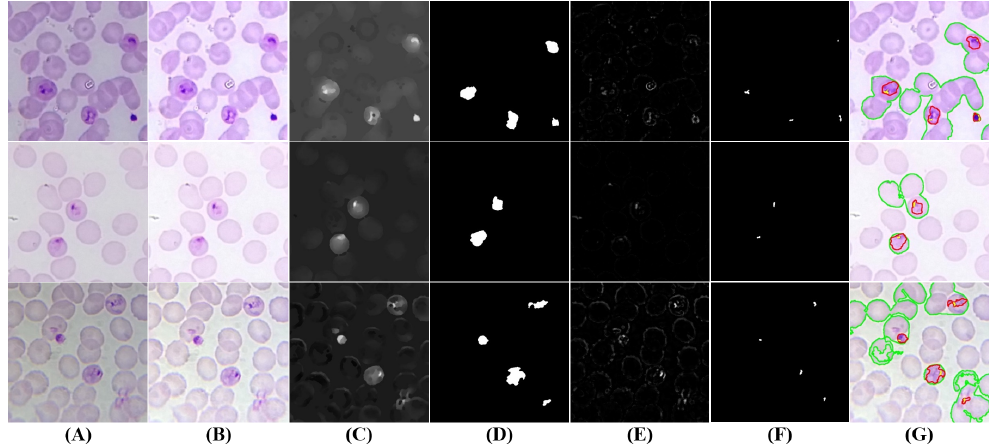
Figure 8. Examples of mature trophozoite stage candidates: ( A ) original image (cropped ROI); ( B ) brightness and contrast enhancement; ( C ) cytoplasm grayscale sharpening; ( D ) cytoplasm segmentation and filtering; ( E ) chromatin grayscale sharpening; ( F ) chromatin segmentation and filtering; ( G ) final candidates (cytoplasm in red; chromatin in yellow; RBC with candidate inside in